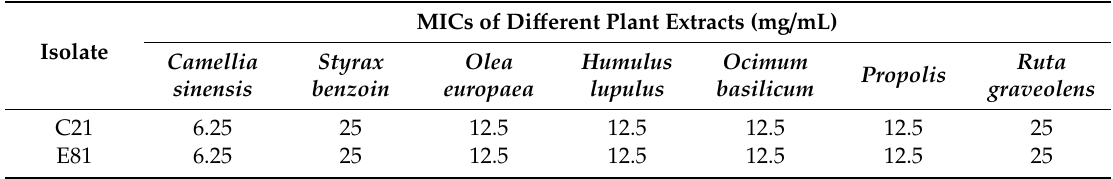
tea) with MIC value 6.25 mg / mL, followed by Olea europaea (olive) extract with 12.5 mg / mL. Table 3. Determination of MICs of plant extracts against the selected strong biofilm producer isolates. MICs of Di ff erent Plant Extracts (mg / mL) Isolate Camellia sinensis